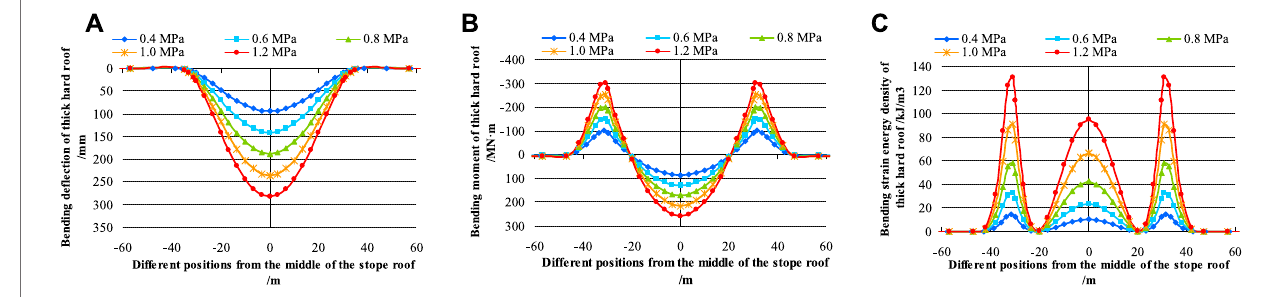
FIGURE 4 | Mechanical in fl uence characteristics of the overlying load in the mining exposed area on the mining bearing capacity of the thick hard roof. (A) Distribution characteristics of bending de fl ection. (B) Distribution characteristics of stressed bending moment. (C) Distribution characteristics of elastic energy accumulation.